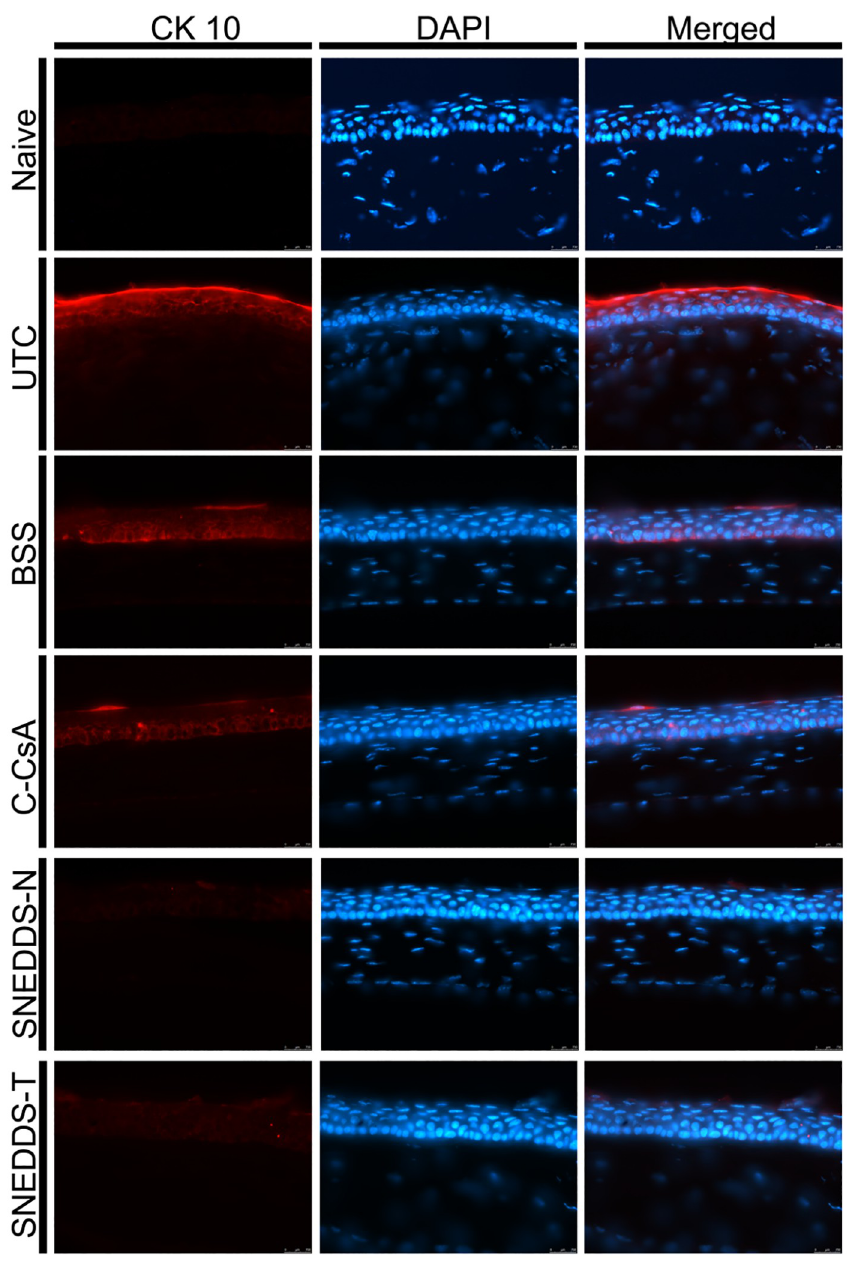
Fig 5. Representative images for immunofluorescent staining of CK-10 in central cornea to assess corneal epithelial squamous metaplasia in the untreated control, BSS-treated, C-CsA-treated, SNEDDS-N-treated and SNEDDS-T-treated